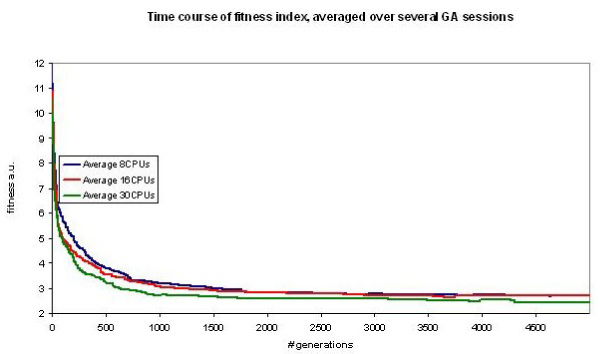
Fitness index. Time evolution of the fitness index, during the calculation of the optimal sets of kinetic parameters. The diagrams describes the fitness evolution of the optimal individuals as a result of parallel calculations on 8, 16 and 30 CPUs and are the average over different session, this explains the small discontinuities in the decreasing trend. The time required to reach the saturation decreases as the number of CPUs increases.